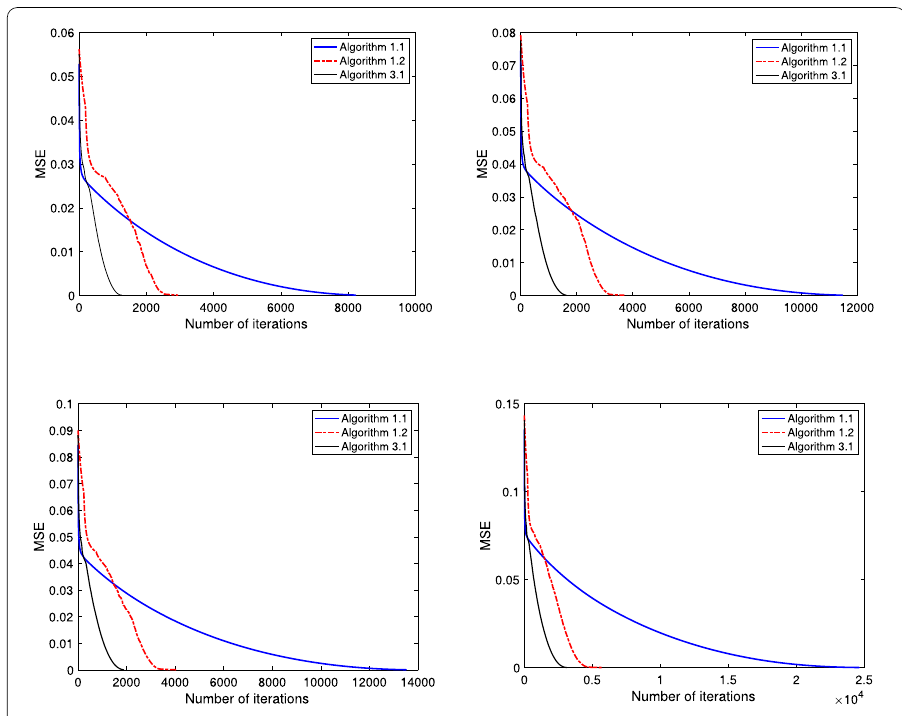
Figure 1 The MSE value and number of iterations for all cases when N = 1024 and M = 512